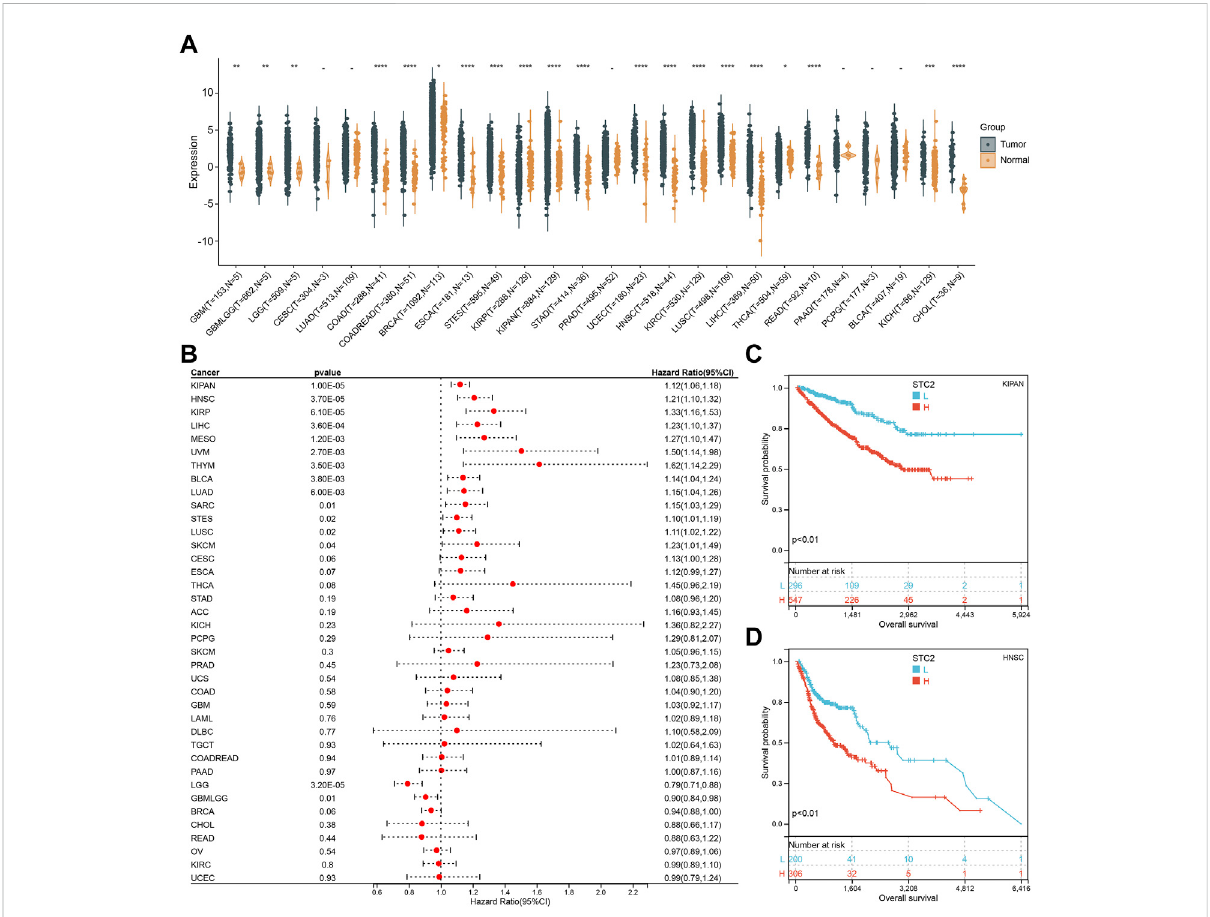
FIGURE 3 Pan-Cancer Expression Landscape of STC2. (A) STC2 expression across 26 types of human cancer; (B) Cox regression showing the correlation between STC2 expression and OS; (C,D) Two presentative Kaplan-Meier OS curves (KIPAN and HNSC). *: p -value < 0.05; **: p -value < 0.01, ***: p -value < 0.001, ****: p -value <